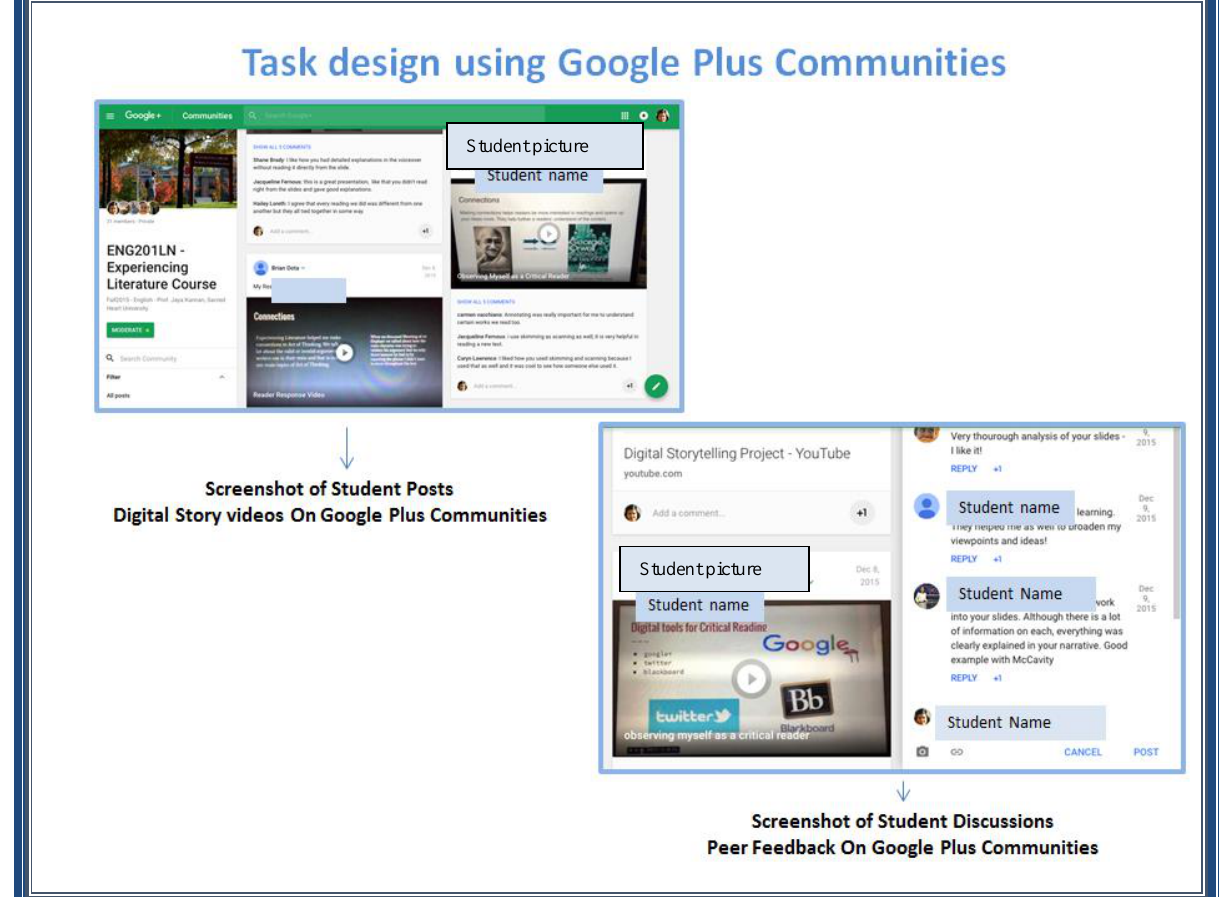
Fig 3 – Task-design using Google Plus